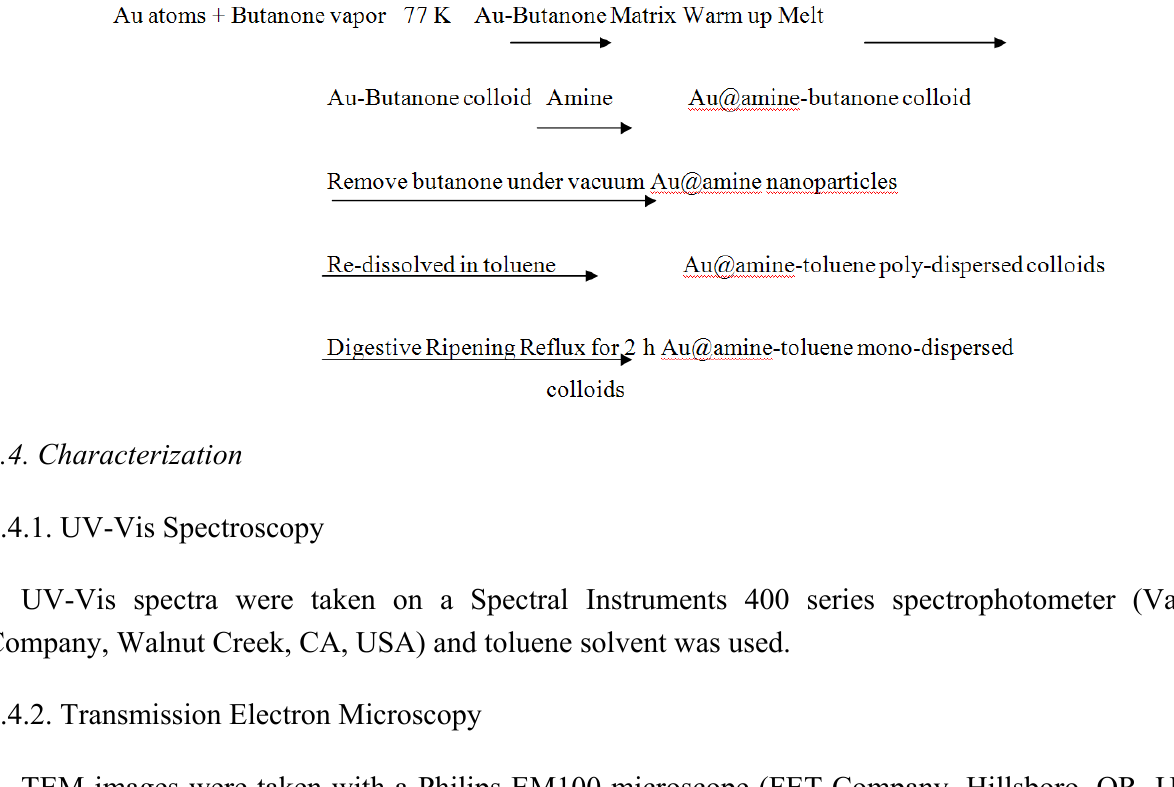
Figure 2. Schematic representation of the synthesis of gold colloid by Solvated Metal Atom Dispersion (SMAD) method and digestive ripening